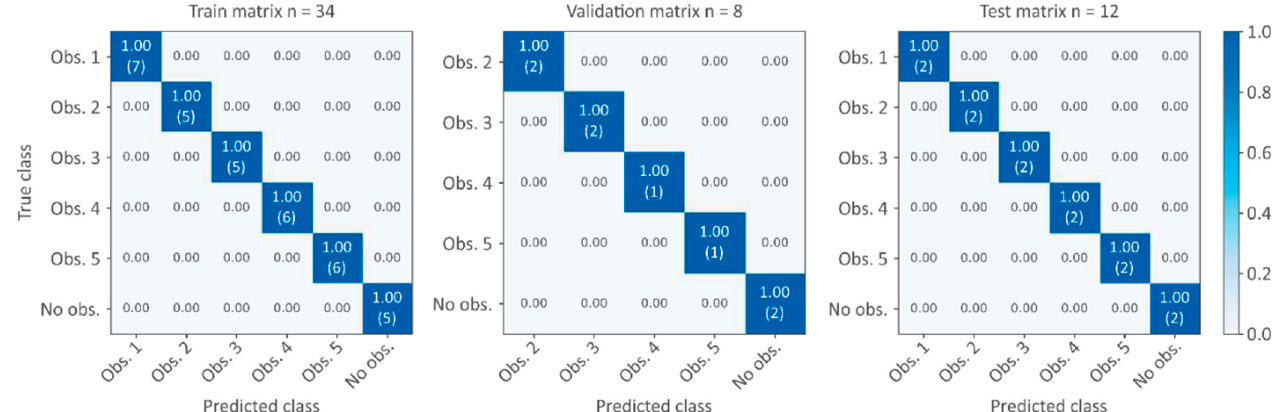
Figure 6. Confusion matrix for training, validation, and test datasets (42 simulated scenarios; 12 measured scenarios) using five nodes, i.e., a node per pool (obs. = obstruction; n = number of scenarios). The numbers in the matrix correspond to percentages (sum by row = 1.00) while the numbers between parentheses correspond to the number of scenarios.